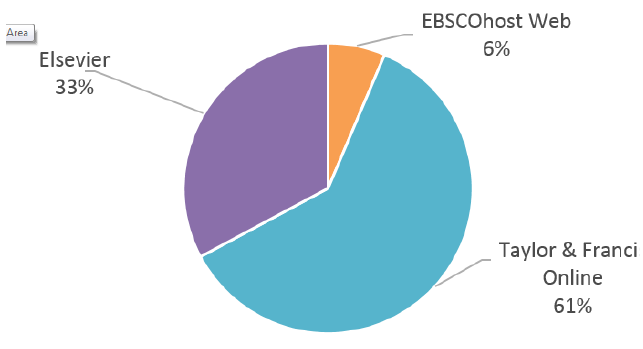
Figure 1: Percentages of articles on preferences for and perceptions of greenspaces based on the 45 located articles